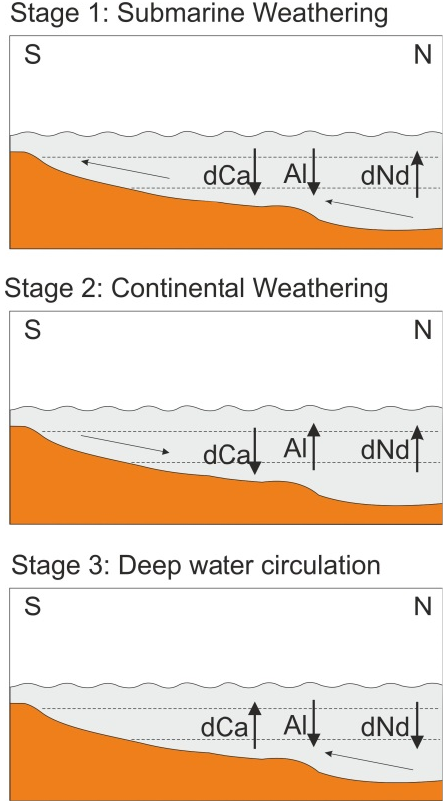
Figure 11. The three proposed models of the phosphate deposition.